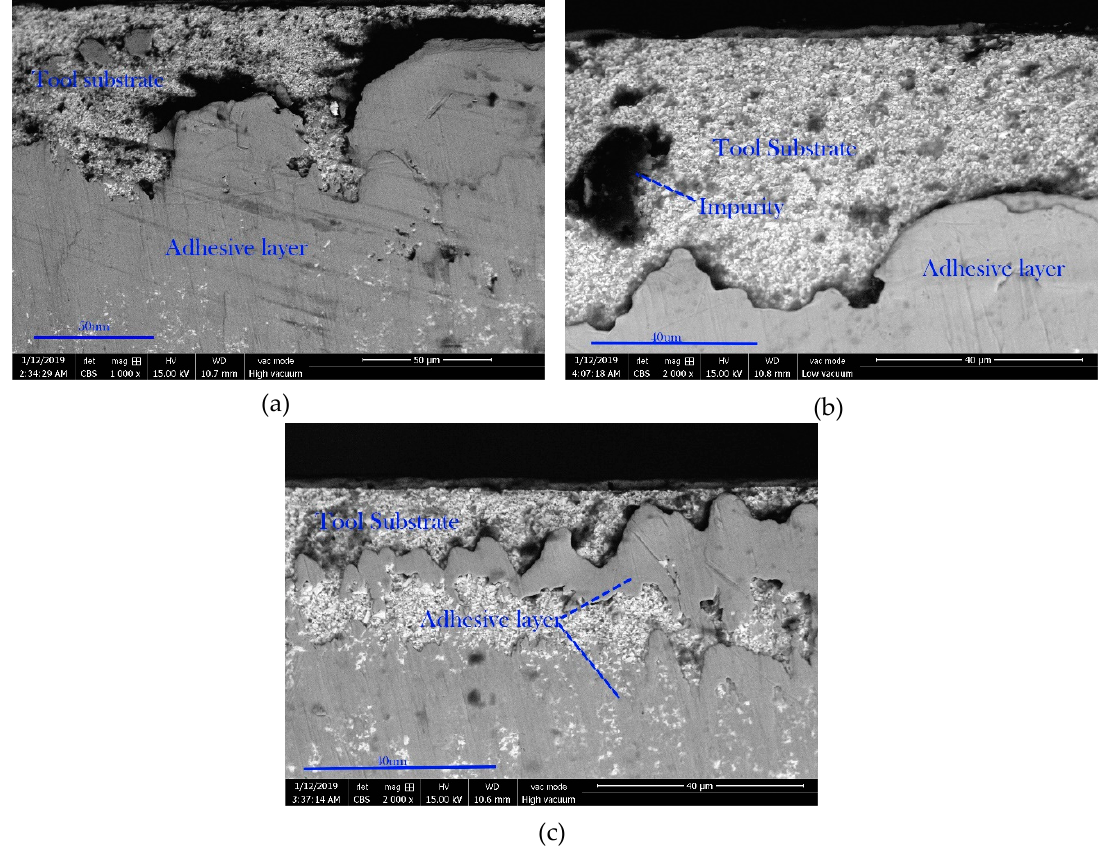
Figure 3. Tool wear patterns. ( a ) tool wear pattern at 150 m / min cutting speed; ( b ) Tool wear pattern at 200 m / min cutting speed; ( c ) Tool wear pattern at 250 m / min cutting speed.